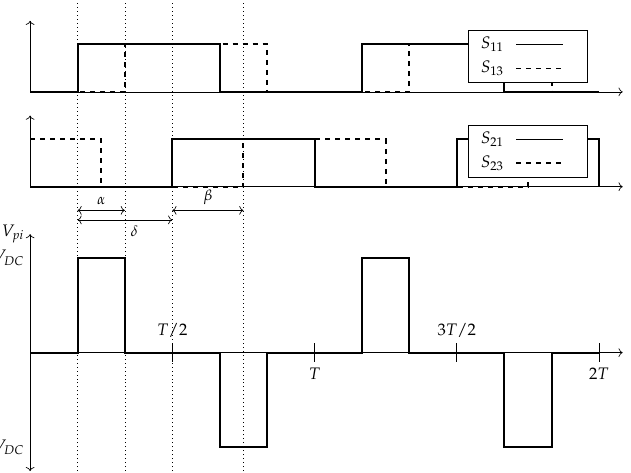
Figure 10. Activation signals of the transistors of the power